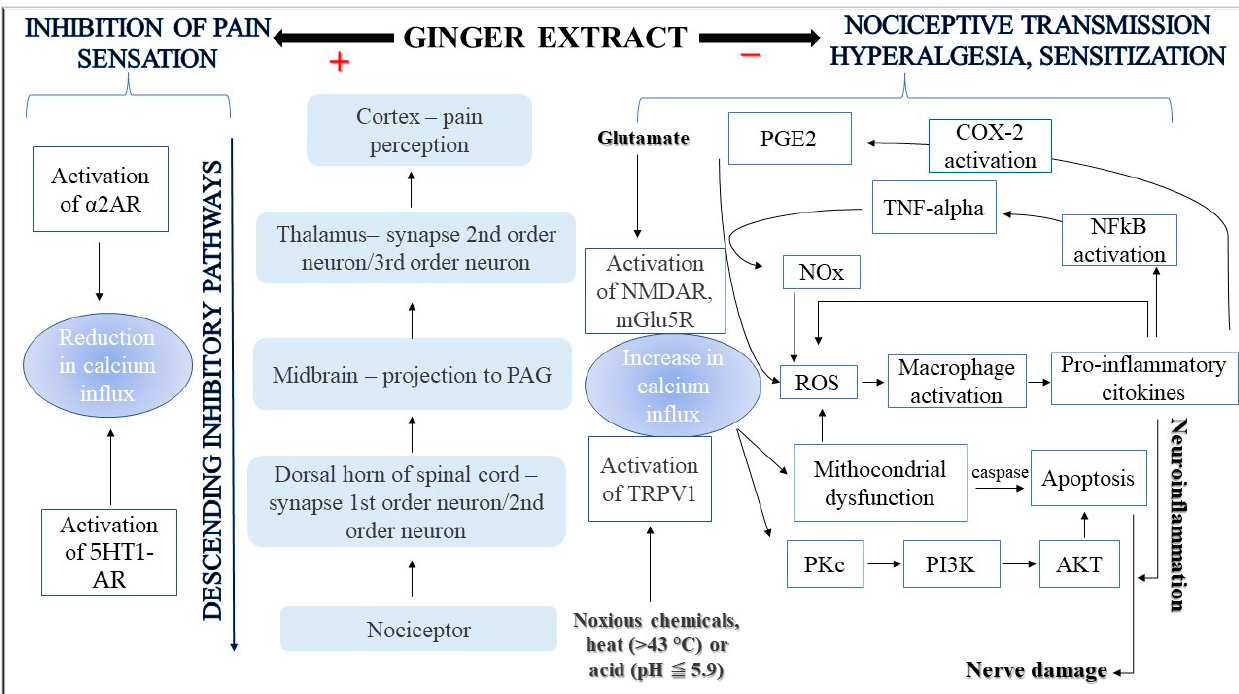
Figure 3. The main mechanisms mediating the antinociceptive effect of ginger extract. Legend: 5HT1-AR, serotoninergic receptor subtype 5HT1-A; α 2AR, adrenergic receptors α 2A; AKT, protein kinase B; COX-2, cyclooxygenase 2; mGlu5R, metabotropic glutamate receptors 5; NF-kB, nuclear factor-kappa B; NMDAR, glutamatergic receptor subtype NMDA; NOx, NADPH oxidase enzymes; PAG, periaqueductal gray; PGE2, prostaglandin E2; PI3K, phosphoinositide 3-kinases; PKc, protein kinase C; ROS, reactive oxygen species; TRPV1, transient receptor potential cation channel subfamily V member 1.